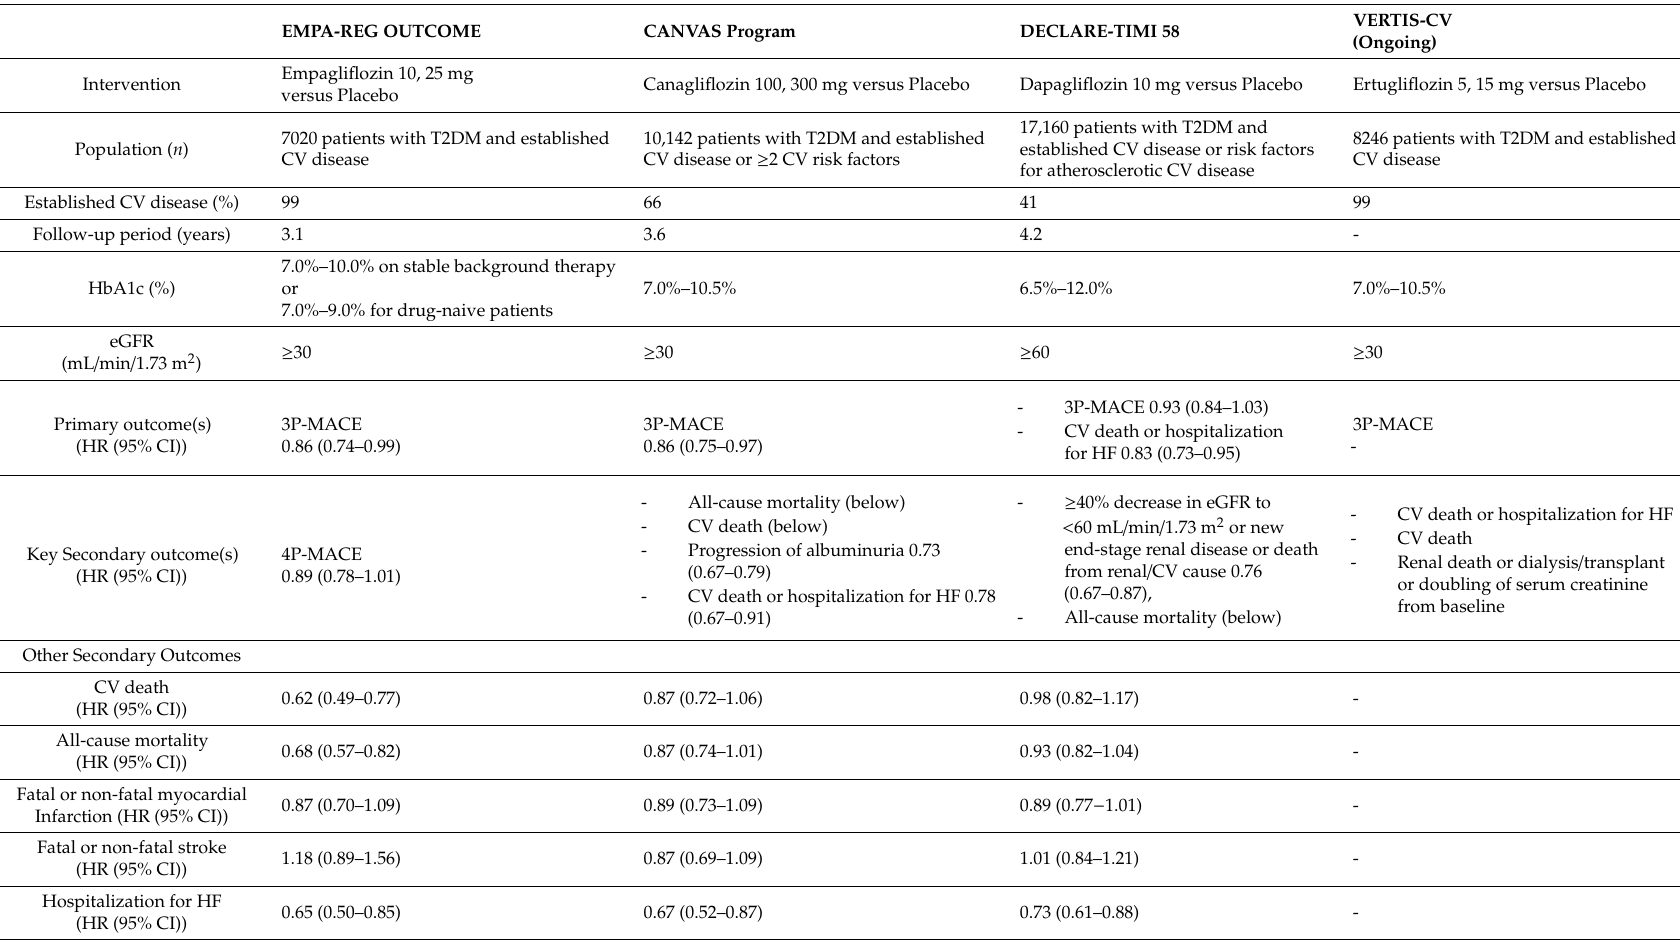
Table 1. Basic characteristics of the cardiovascular safety studies of